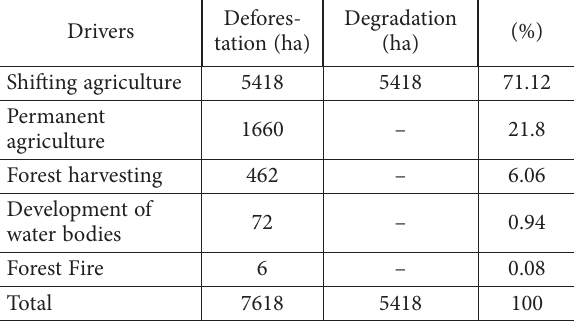
Figure 3. Distribution of the deforestation and forest degradation drivers for period (2009–2013) Table 3. Drivers of deforestation and forest degradation in the Man River basin from 2009 to 2013 by integrated assessment